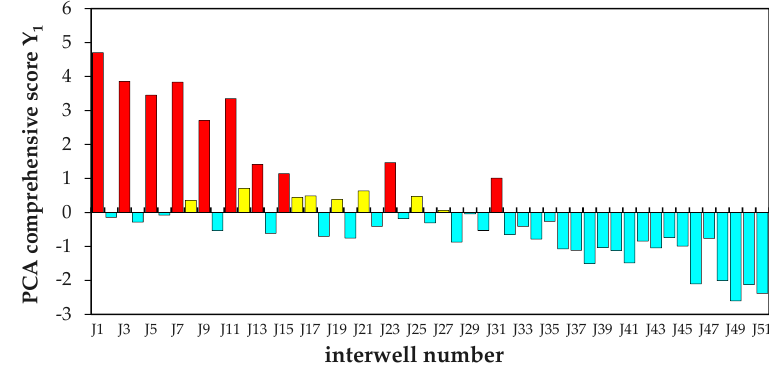
Figure 4. PCA comprehensive score.